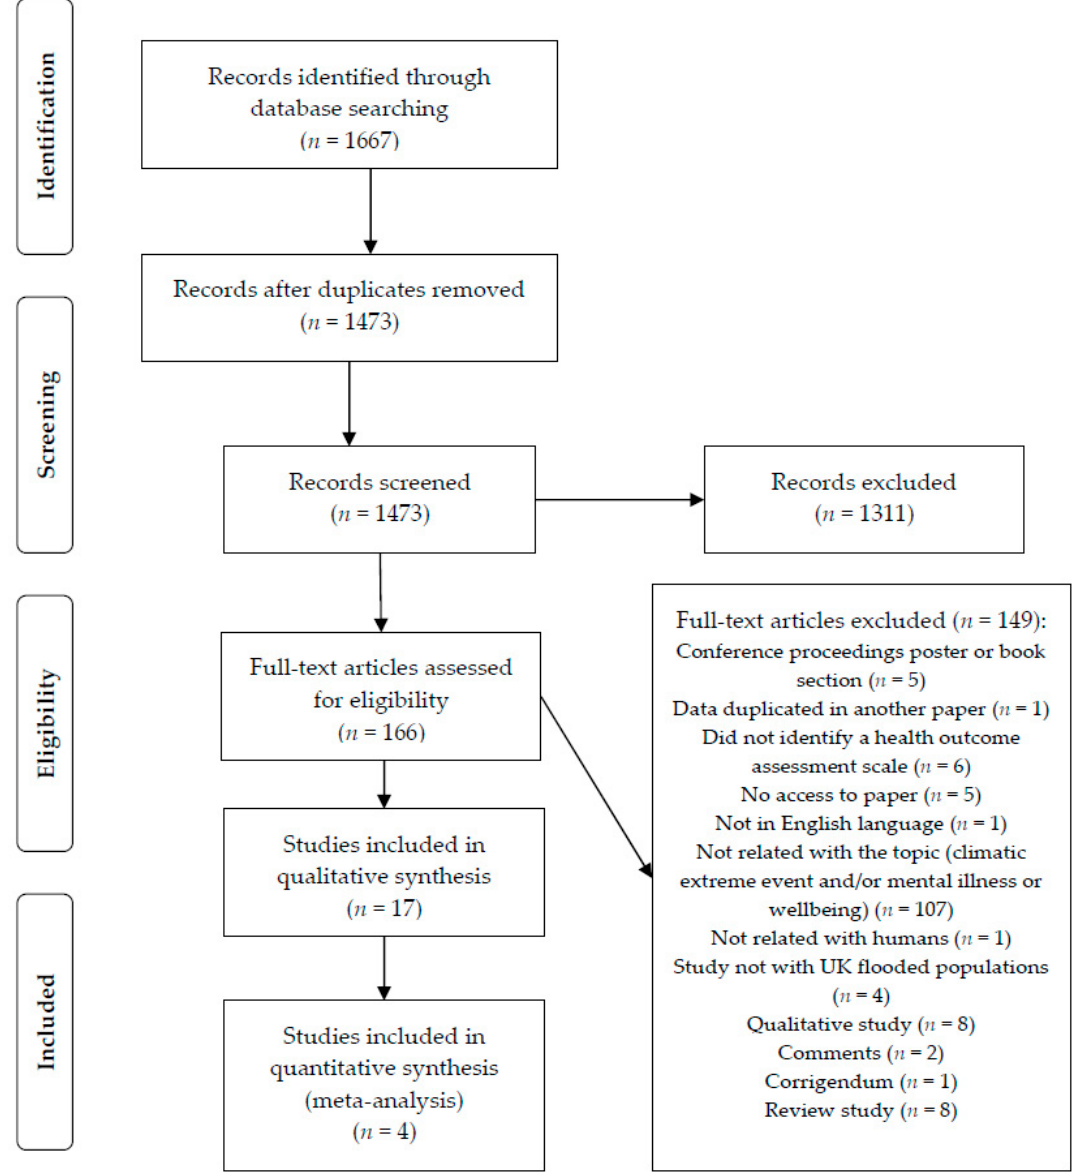
Figure 1. Preferred Reporting Items for Systematic Reviews and Meta-Analyses (PRISMA) flow chart of study identification process.